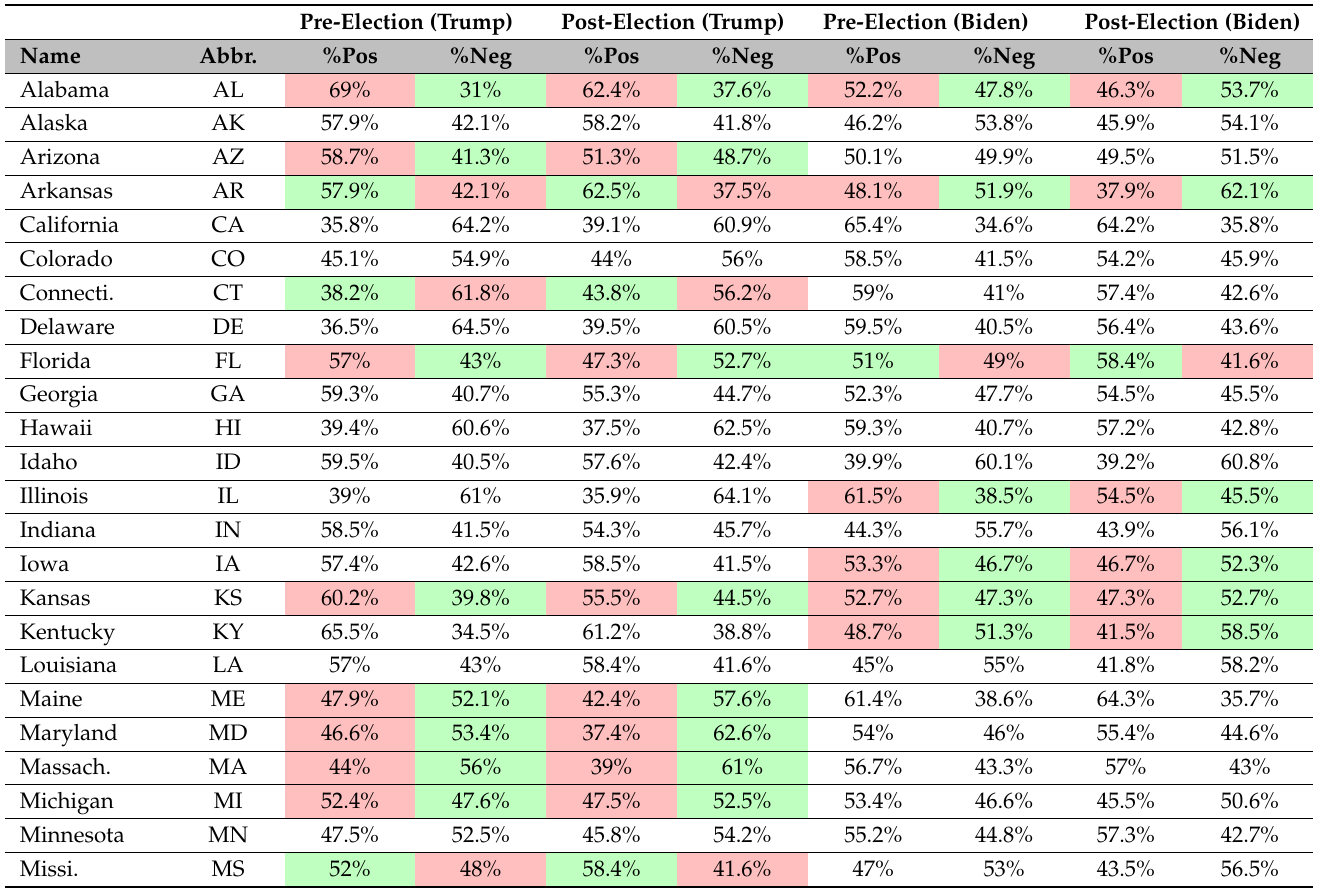
Table 2. Pre and post-election sentiment drift of users on